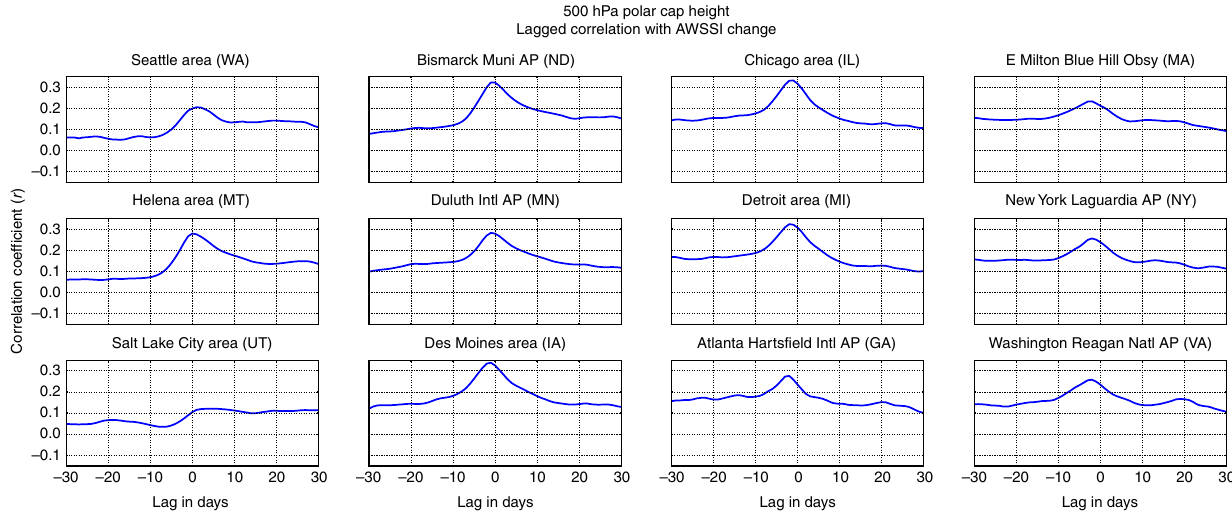
Fig. 5 Arctic variability leads occurrence of severe winter weather. The correlation between average daily change in the AWSSI at selected weather stations across the US associated with polar cap geopotential height anomalies (PCH) for all days between ± 30 days. The peak value is reached when the PCH leads the AWSSI by 5